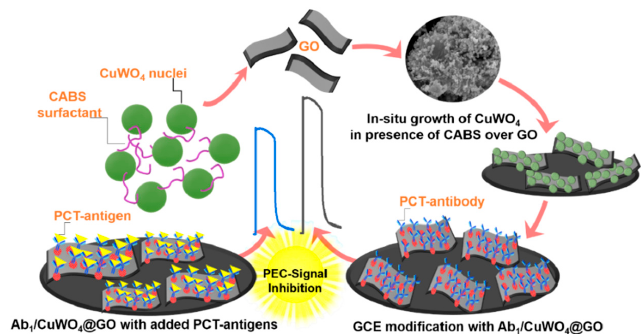
Figure 1. A generalized scheme, portraying in situ growth of CuWO 4 nanospheres over reduced graphene oxide (rGO) flakes and the hybrids use in photoelectrochemical (PEC) electro-catalytic immunosensing of procalcitonin (PCT) biomarker where signal inhibition is the consequence of the antibody–antigen reaction occurring at the surface of CuWO 4 @rGO hybrids. CAPB, cocamidopropyl betaine, GCE, glassy carbon